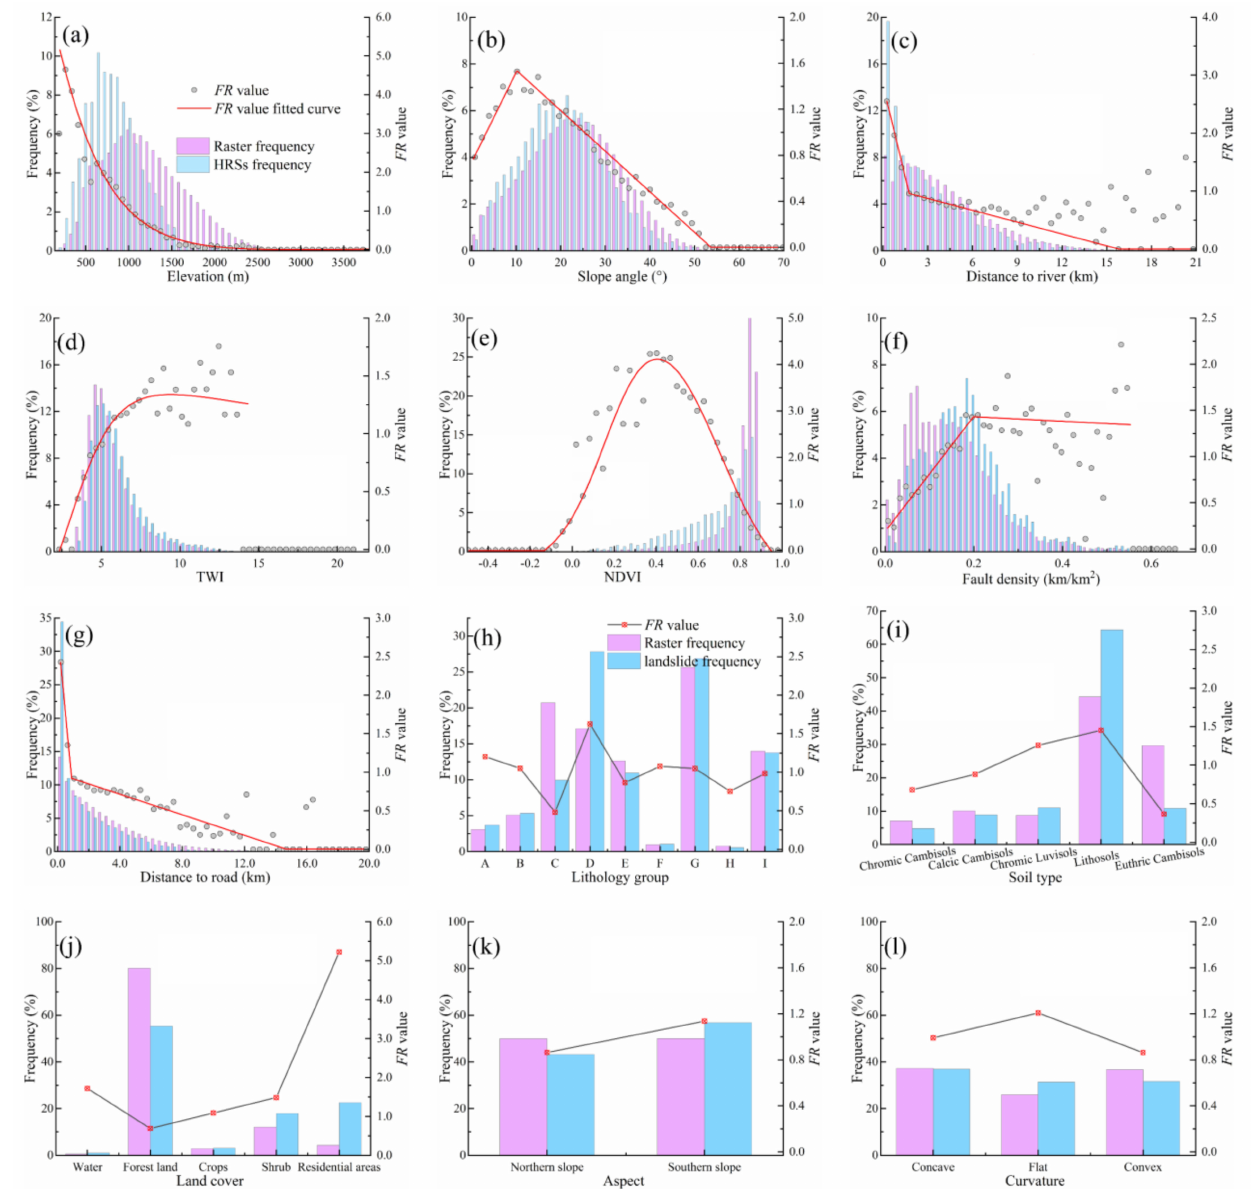
Figure 4. The relationship between the geoenvironmental factor values and FR value; ( a – g ) refer to the continuity factors, ( h – l ) refer to the discrete